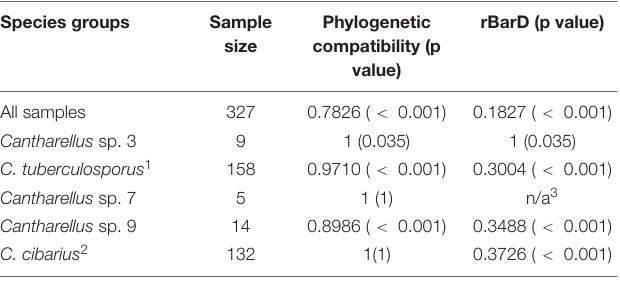
TABLE 2 | Association among SNPs at the atp6 gene for C. cibarius and related species across southwestern China and Europe. Species groups Sample Phylogenetic size compatibility